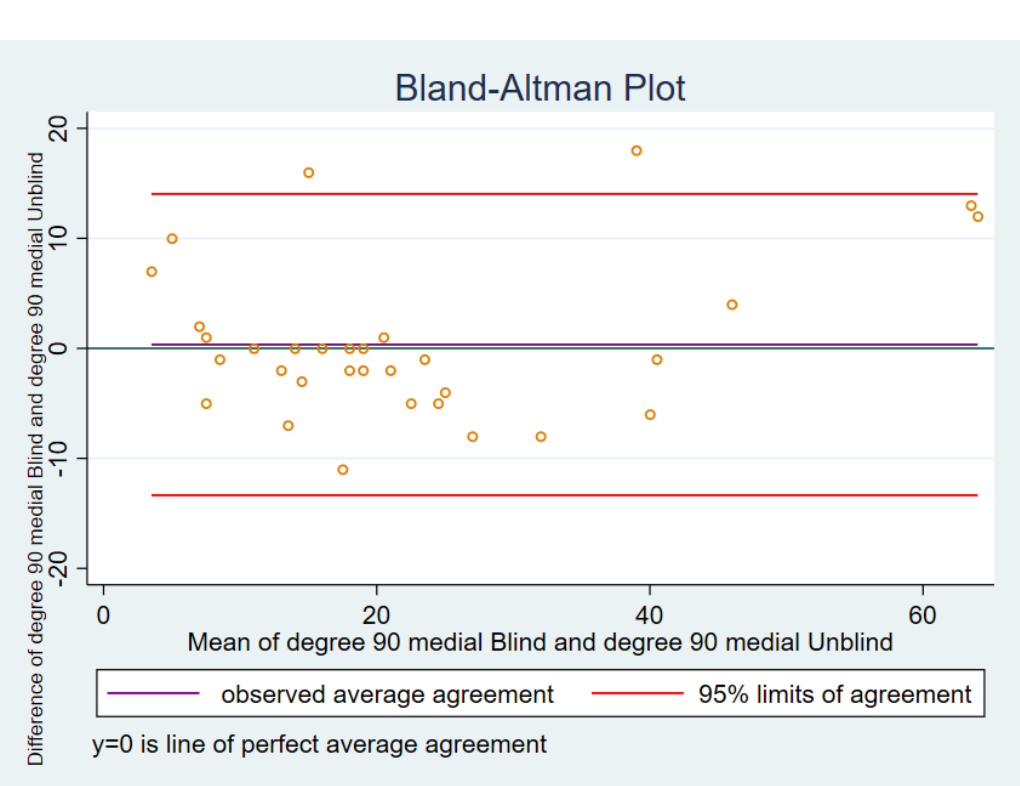
Figure A8. Ninety degrees, medial.